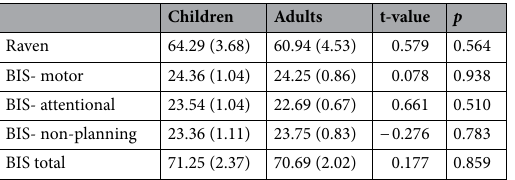
Table 1. Means and standard errors (SEs) of Raven’s scores and the scores of BIS-11 in children and